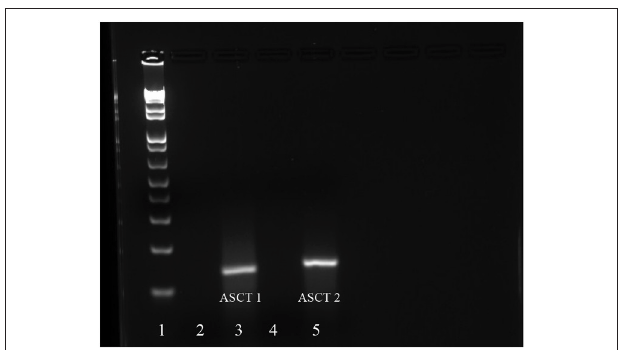
FIGURE 7 | mRNA expression of ASCT1 and ASCT2 in mES cells as determined by RT-RCR. Lane 1: DNA ladder; Lane 2: ASCT1 primers and no RNA template control; Lane 3: ASCT1 primers and template RNA; Lane 4: ASCT2 primers and no template RNA control; Lane 5: ASCT2 primers and template